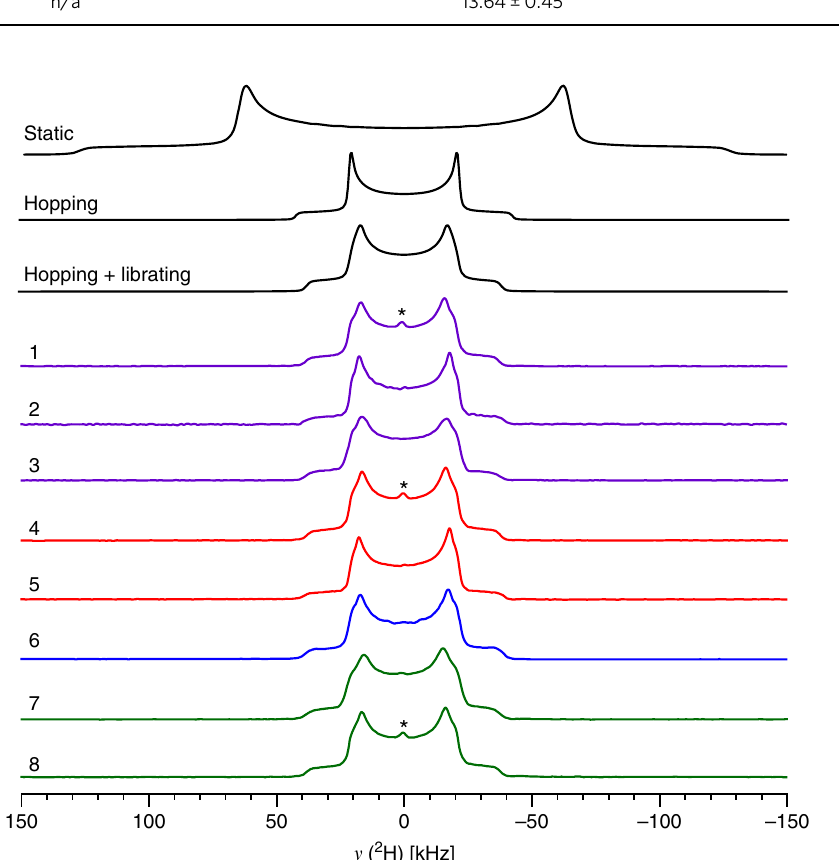
Fig. 2 Experimental static deuterium ( 2 H) solid-state NMR spectra of compounds 1 – 8 at room temperature. In black are the simulated spectra, in purple are the halogen bonded species, in red are the hydrogen bonded species, in blue is pure TMP, and the halide salts are in green. The asterisks denotes a trace quantity (<1%) of D 2